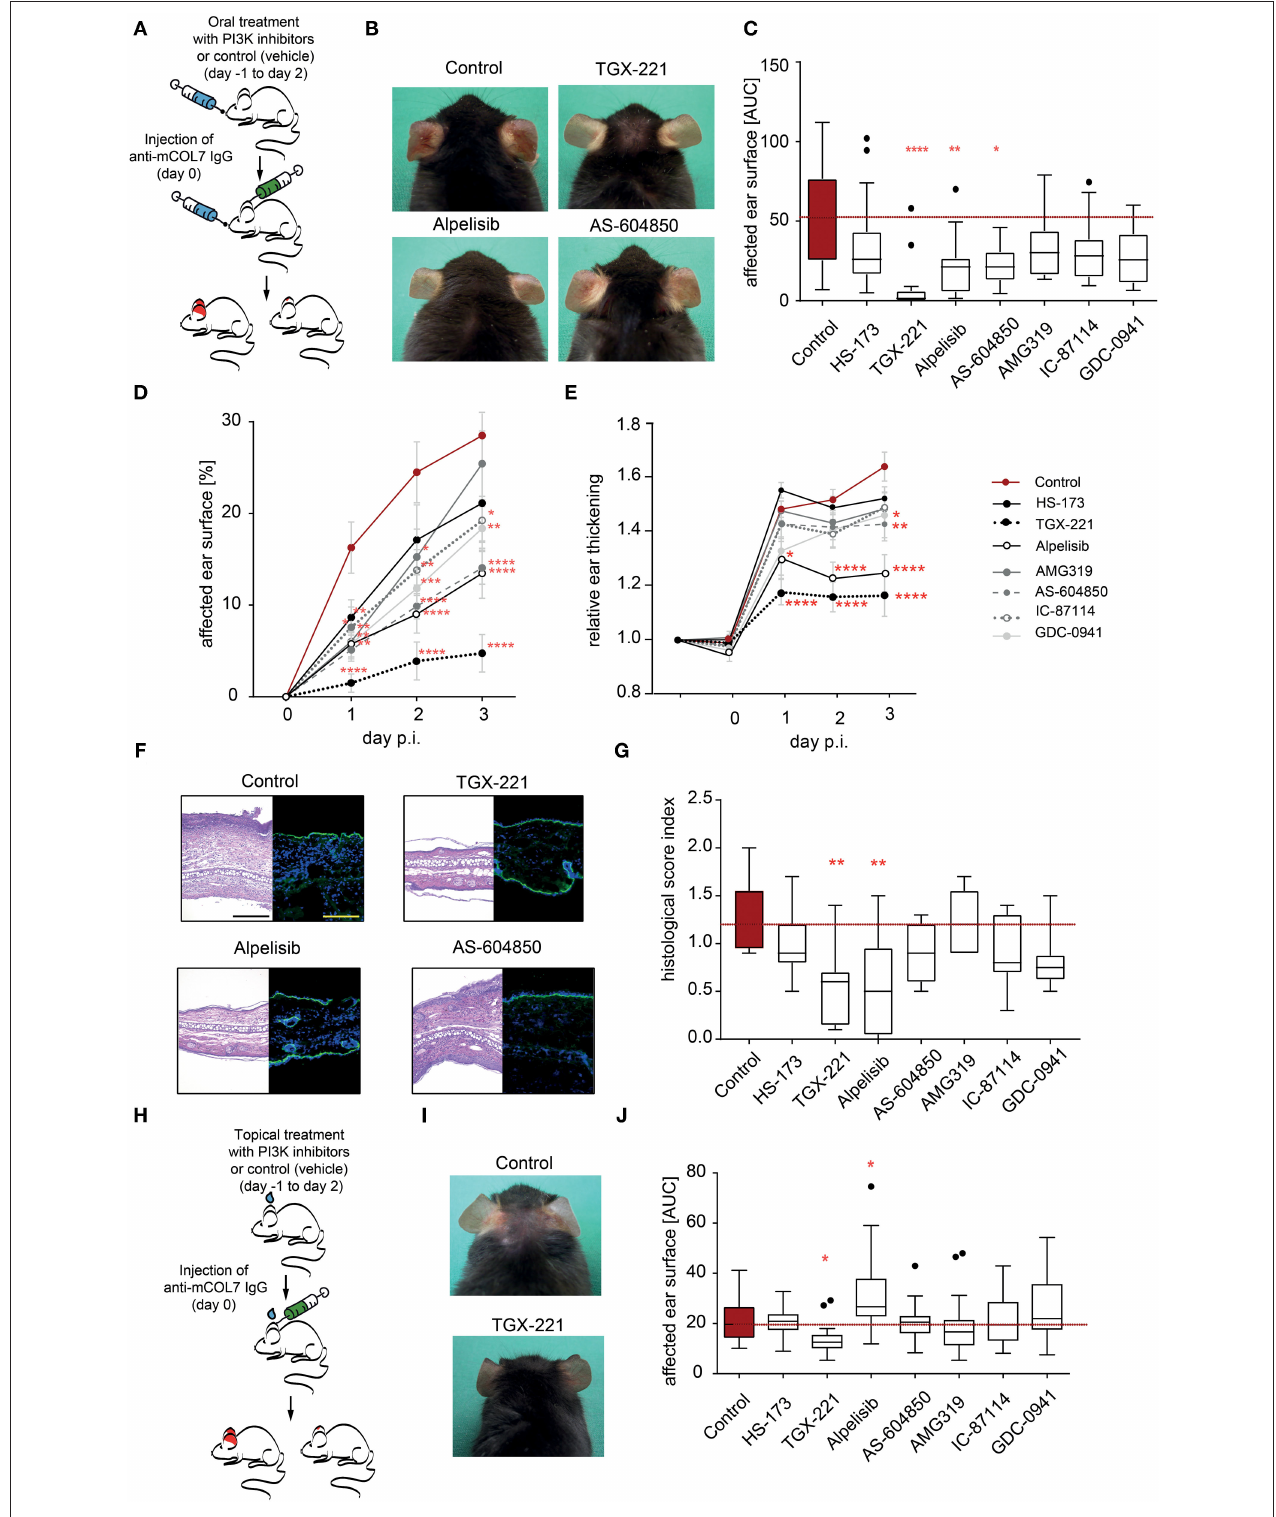
FIGURE 4 | Treatment with TGX-221, alpelisib or AS-604850 impairs induction of experimental EBA. (A) Schematic illustration of experimental work flow. Anti-mCOL7 IgG was injected into the ears of C57BL/6J mice and the mice were orally treated with the indicated PI3K isoform selective inhibitors. (B) Representative clinical images of the mice on day 3. (C) The cumulative affected ear surface area (AUC) in mice treated with solvent or the indicated PI3K inhibitors. Data are shown